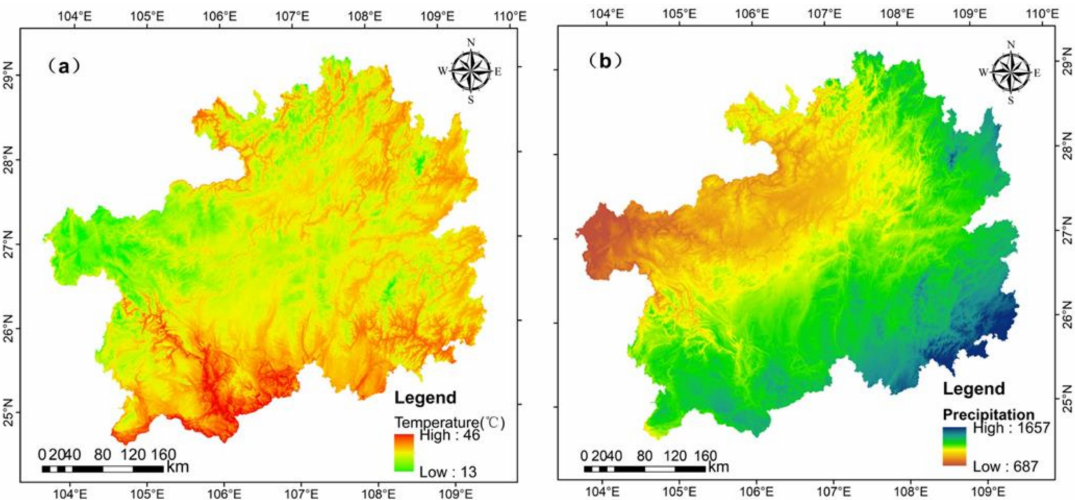
Figure 4. Spatial distribution of meteorological data-temperature ( a ) and precipitation ( b )—on the Guizhou